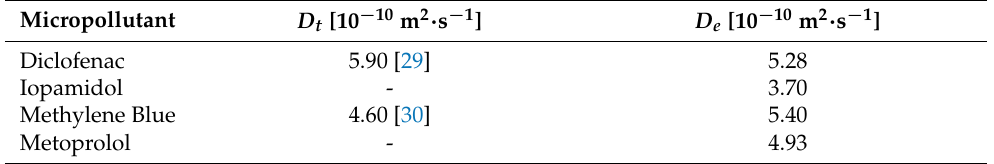
Table 1. Diffusion